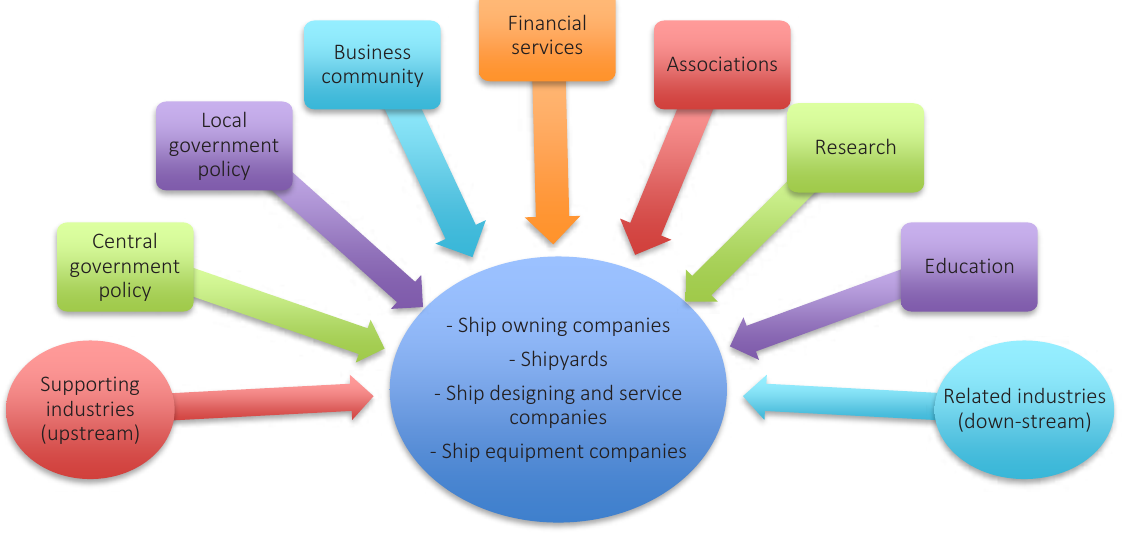
Figure 4. BMC and its